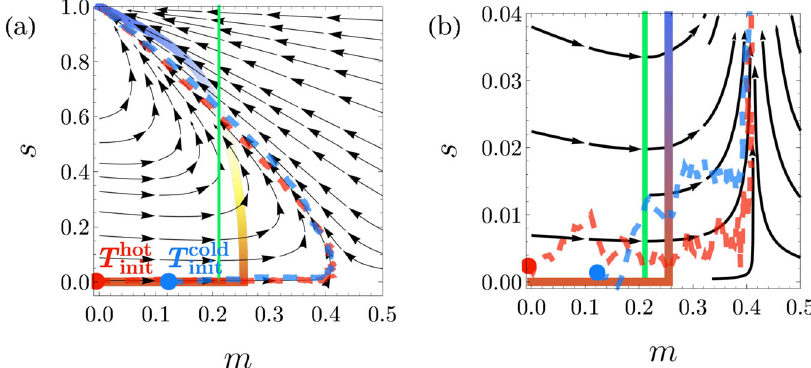
Fig. 5 Finite time phase transition in the mean- fi eld Ising model. a The equilibrium line of the anti-ferromagnet for h = 0.5. The equilibrium line corresponds to solving _ s ¼ 0 ; _ m ¼ 0 given in Eqs. (20), (21)). Temperatures range from T = ∞ to T = 0 that correspond to red and blue, respectively. The arrows indicate the fl ow of the macroscopic parameters for the bath temperature T b = 0.2. b Inset of panel a showing the stability of the fl ow _ s ; _ m with respect to the symmetry line s = 0 at bath temperature T b = 0.5. The red-blue line is the relevant part of the equilibrium line which is shown fully in panel a . The green line denotes the separation of the two stability regions: the left part is the stable region for which ∂ s _ s j s ¼ 0 ; m < 0, and the right part is the unstable region for which ∂ s _ s j s ¼ 0 ; m > 0, see Eq. (22) and Fig. 4. The fl ow, denoted by the black arrows, shows the stability trends. All initial conditions on the left of the green line have fi nite non-zero “ phase transition time ” t c . The dashed red and blue lines correspond to stochastic trajectories of the system starting from T hot and T cold , respectively. These two trajectories are an illustration showing that no Mpemba effect exists in this system. Indeed, the colder initial init init condition crosses the stability line (green) before the hotter initial condition.